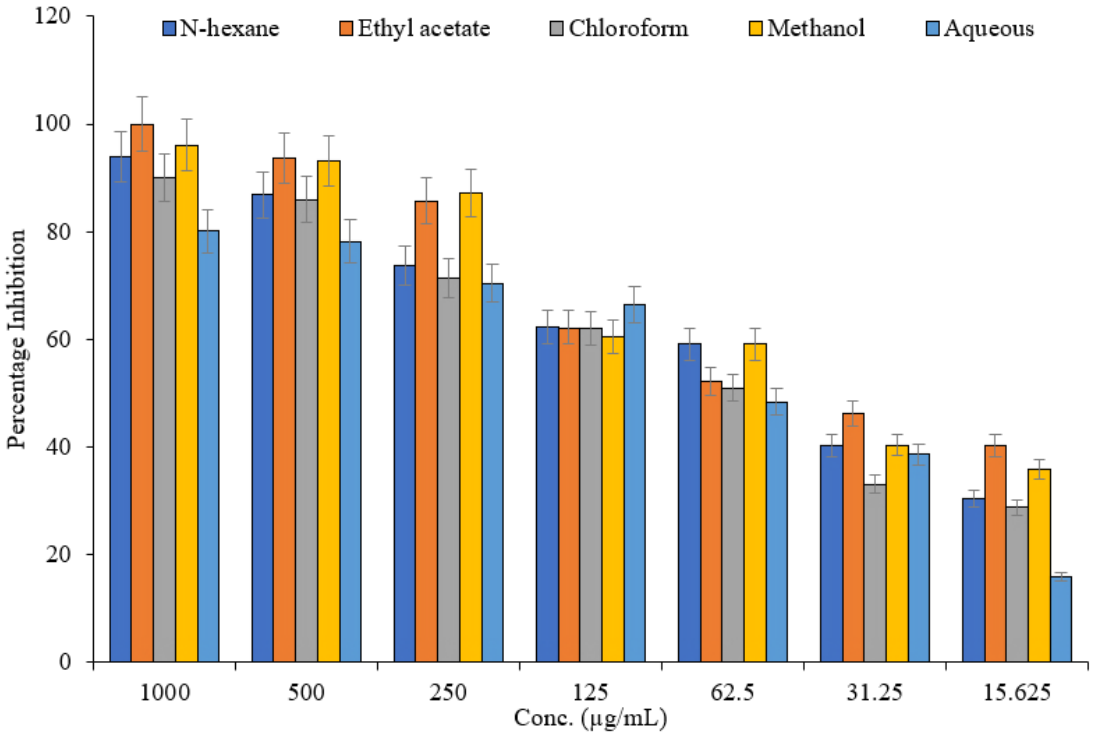
Figure 3. Percentage inhibition of tumors by different fractions of P. harmala (S) extract at different concentrations.